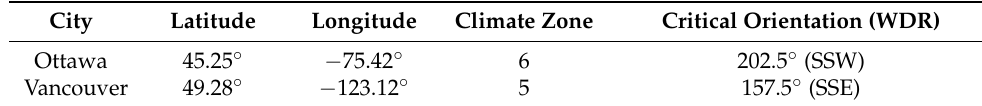
Table 2. Climate and location characteristics of the two Canadian cities selected for hygrothermal simulations.